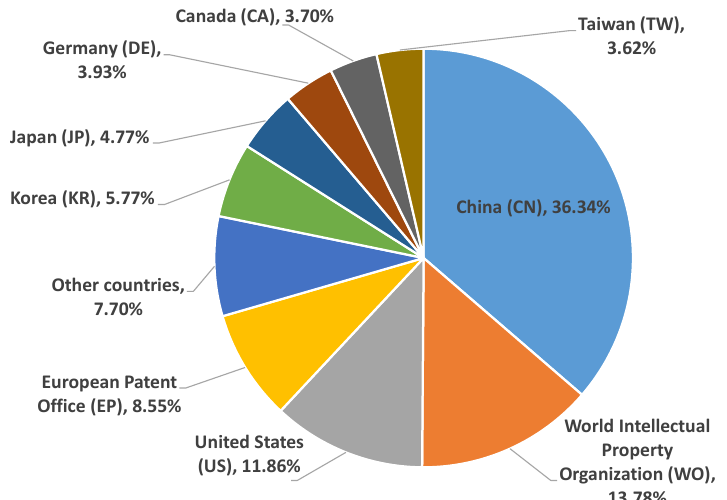
published patents.